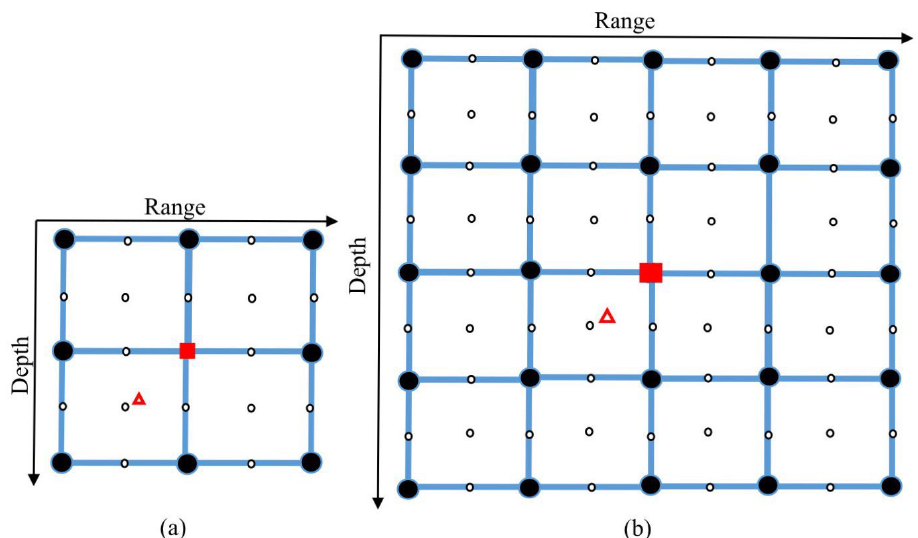
Figure 5. The structure of refined area: ( a ) 2 C r × 2 C d ; ( b ) 4 C r × 4 C d . The refined grid step in depth is F d = C d /2, the refined grid step in range is F r = C r /2. Notation: (cid:52) is the true receiver position, is the coarse location estimate, are coarse grid points, are refined grid